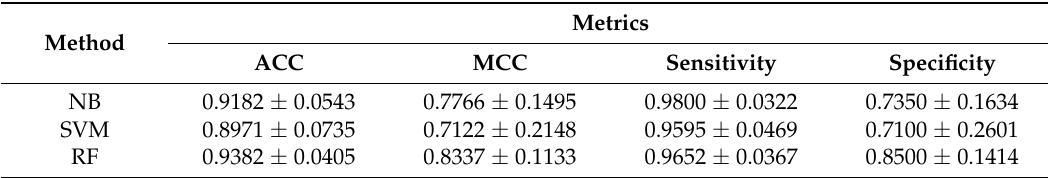
Table 7. Detailed results for random forest (RF), Naïve Bayes (NB) and